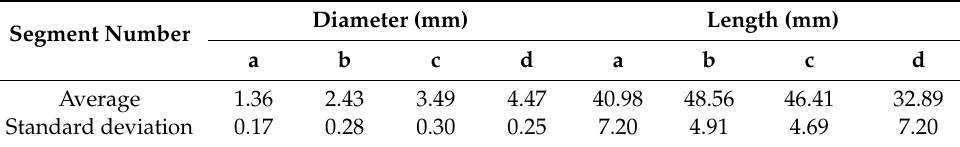
Figure 1. The maize stubble ( a ) Root system of maize; and ( b ) SMR. Table 1. Segment length and diameter of an